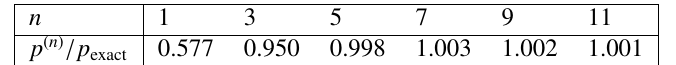
Table 1. Pole positions in the complex p -plane corresponding to the ground state. The pole position is given with respect to the exact value im α .